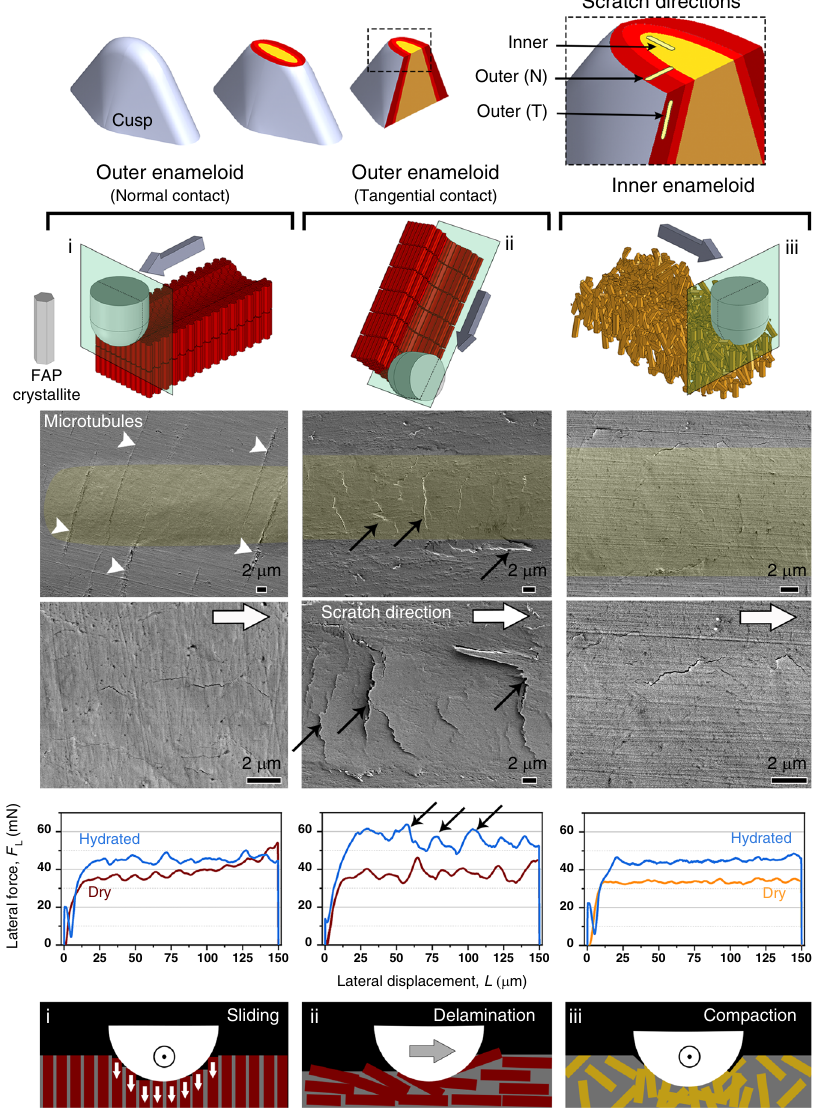
Fig. 6 Scratch-induced damage mechanisms in the different layers of the enameloid. Post-scratch FESEM micrographs revealing the different induced damage modes, namely intercrystalline sliding (left column), delamination (middle column), and compaction (right column), occurring in different enameloid regions and under different loading orientations (also from left to right): in the outer layer under normal contact (biting direction), the outer layer under tangential contact (along the c -axis of FAP crystallites), and the inner layer. Scratching in the tangential orientation in the outer layer cause the most severe cracks and delamination across the scratch track, evidenced also by the force fl uctuations in the lateral force-displacement curve (middle column). In hydrated conditions, despite an increment in lateral forces (due to higher contact depths), the pattern of the curves and the nature of the of the damages were consistent with the dry condition (Supplementary Fig. 7). In contrast, scratching in the normal orientation in the outer layer (left column) and inner layer (right column) induces only microcracks along the scratch tracks. The smooth erosion in the inner layer manifested by a wider scratch track and a smooth lateral force-displacement curve indicates compaction damage, which arises from the woven arrangement of the FAP crystallites and eventually prevents the formation of brittle damage. The color designations for tooth regions are the same as in Figs. 3a – c and